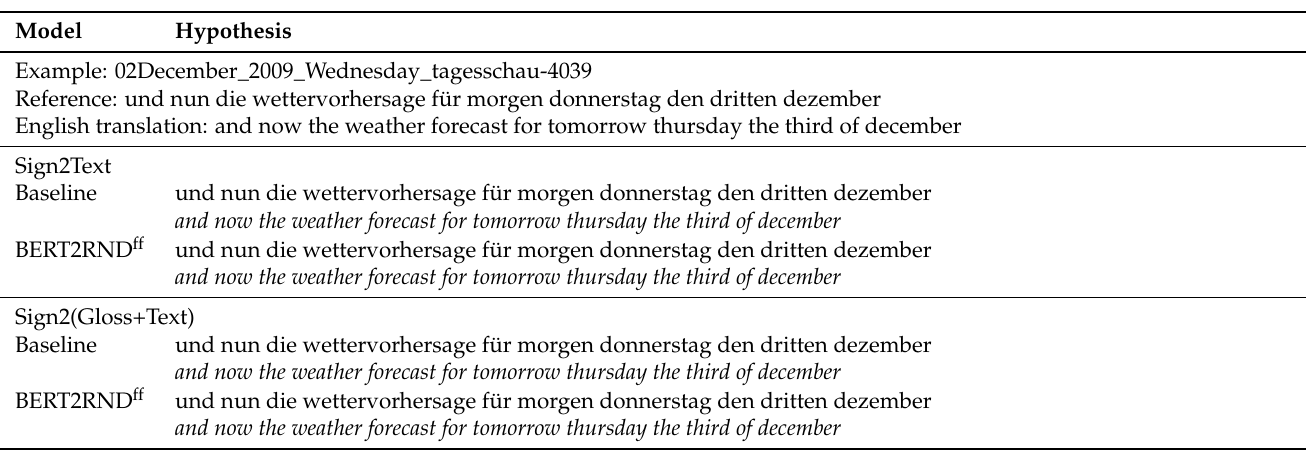
Table 5. Example hypotheses generated by the median BERT2RND ff model and the Baseline model. English translations are obtained using Google Translate (3 out of